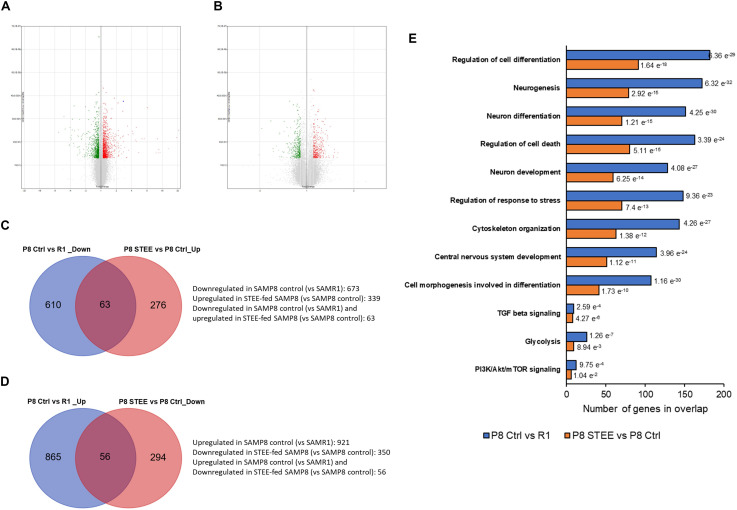
Volcano plot displaying DEGs between (A) SAMP8 control and SAMR1, and (B) STEE-fed SAMP8 and SAMP8 control. In the volcano plot, the vertical axis (y-axis) corresponds to –log10 p-Value of the ANOVA p-Values, and the horizontal axis (x-axis) displays linear fold change. The red dots represent the upregulated genes; the green dots represent the downregulated genes. Venn diagram showing common and unique sets of DEGs between the groups. (C) Blue circle denotes downregulated DEGs in SAMP8 control compared to SAMR1, red circle denotes upregulated DEGs in STEE-fed SAMP8 compared to SAMP8 control. (D) Blue circle denotes upregulated DEGs in SAMP8 control compared to SAMR1, red circle denotes downregulated DEGs in STEE-fed SAMP8 compared to SAMP8 control. (E) Significantly enriched biological processes by the DEGs between the groups (p < 0.05; modified Fisher’s exact test). Each bar represents the number of DEGs in overlap. P values for each gene set are shown at the outside end of each bar.